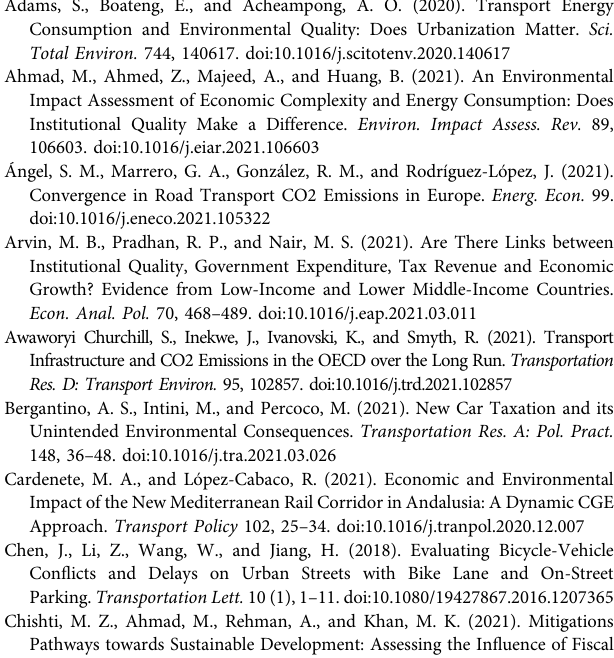
Figliozzi, M. A. (2020). Carbon Emissions Reductions in Last Mile and Grocery DeliveriesUtilizingAirandGroundAutonomousVehicles.